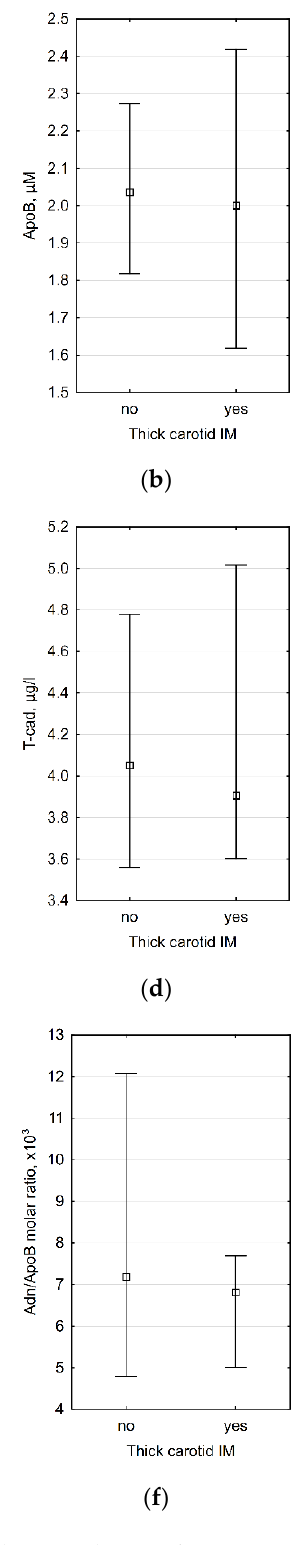
( ≤0.9 mm) carotid intima-media. The comparison of laboratory data between these sub- groups did not reveal any significant differences (Figure 1).